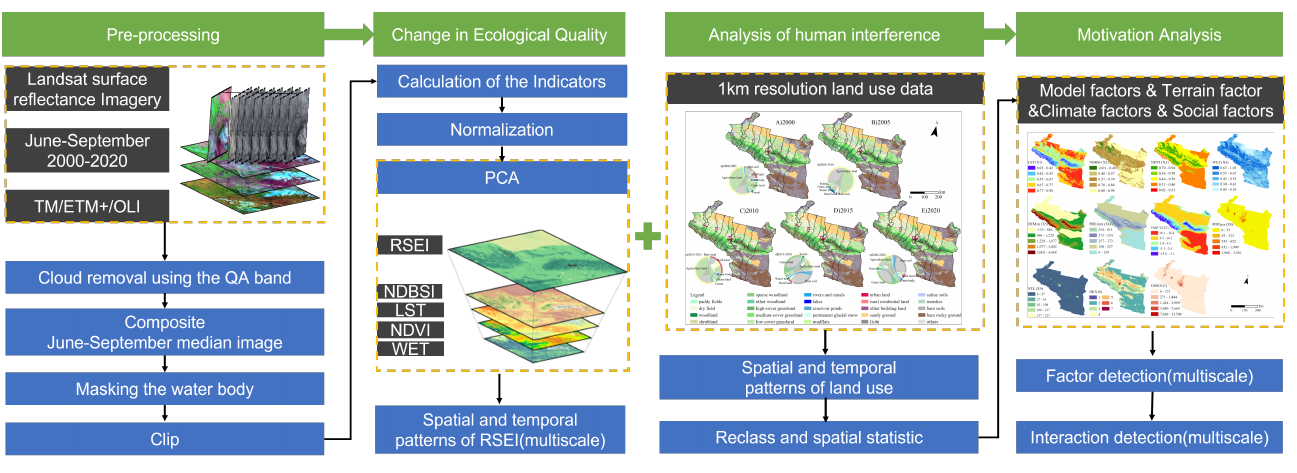
Figure 2. Research framework.